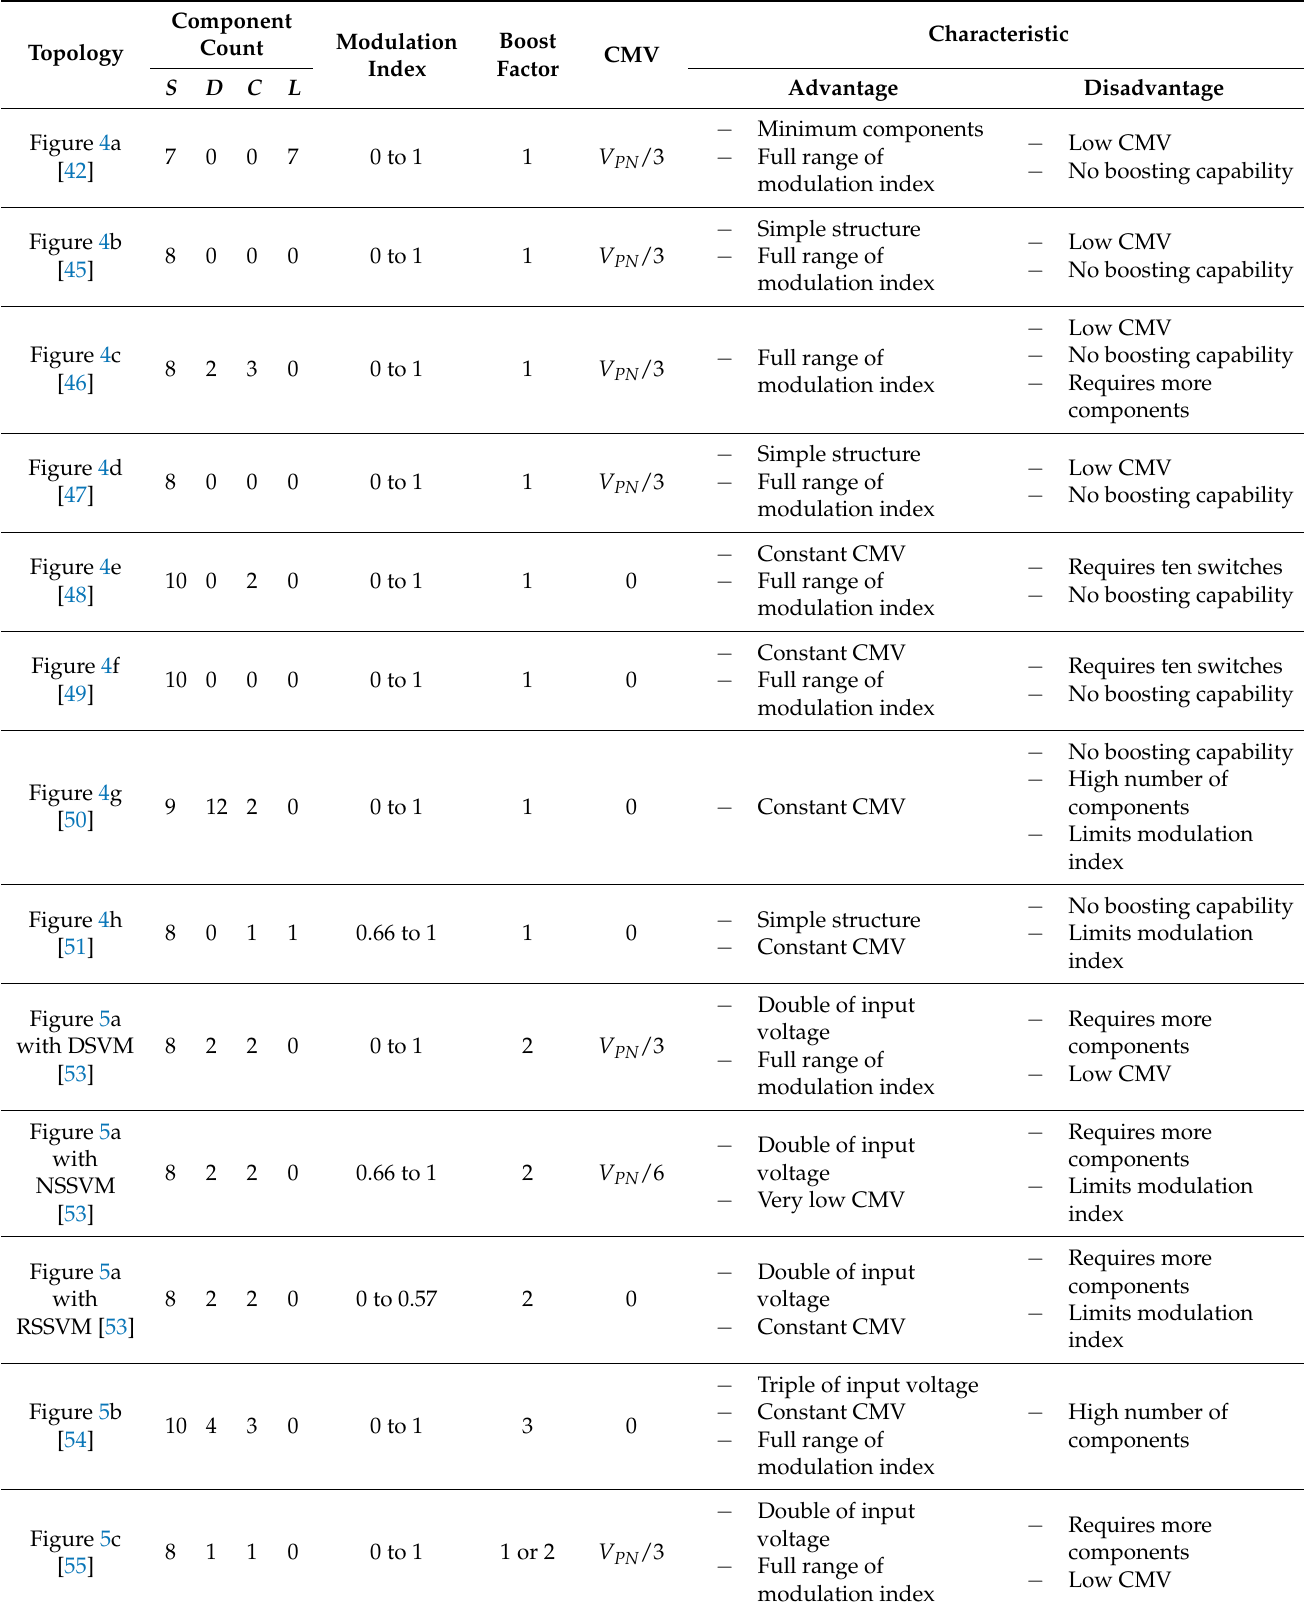
Table 2. Comparison of different CMV reduction traditional VSIs